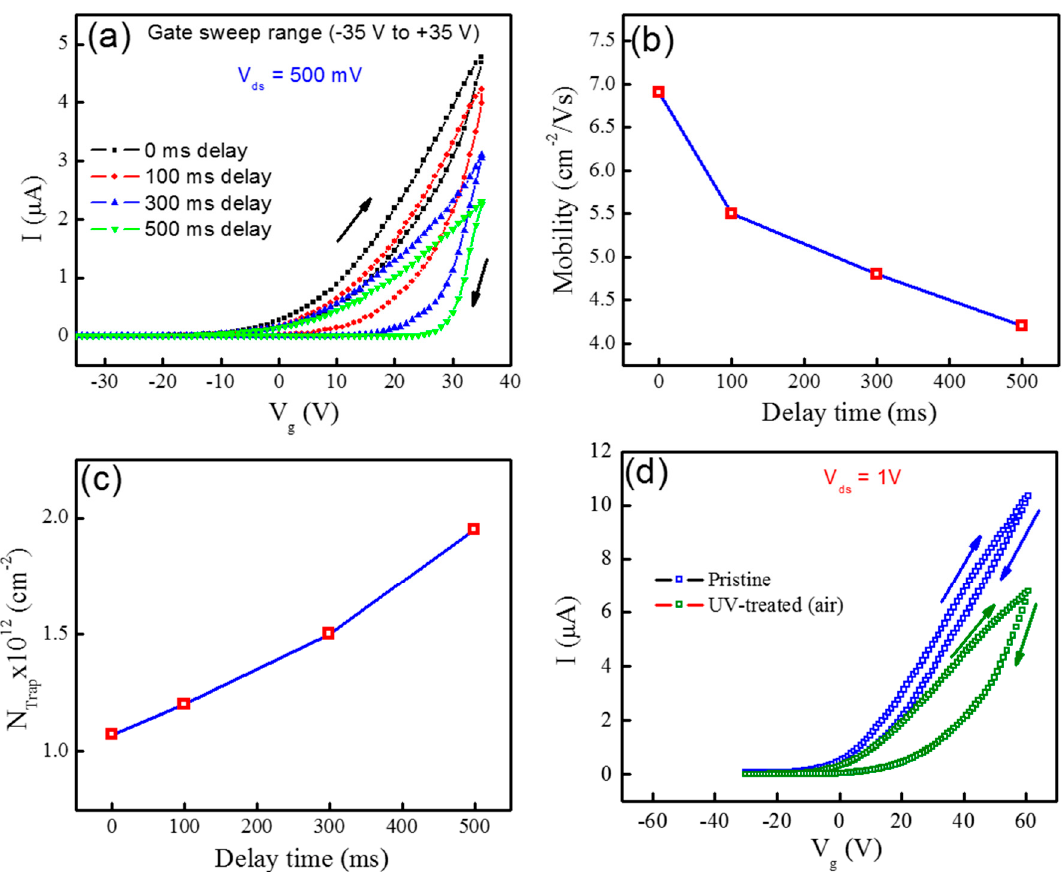
Figure 2. ( a ) Transfer characteristics of the MoTe 2 FET having hysteresis loops at different delay times. ( b ) Mobility as a function of the delay time of MoTe 2 FET. ( c ) Delay time dependent effective trap states density of MoTe 2 /SiO 2 FET. ( d ) The transfer curves before and after UV treatment (10 s) of MoTe 2 /SiO 2 FET.